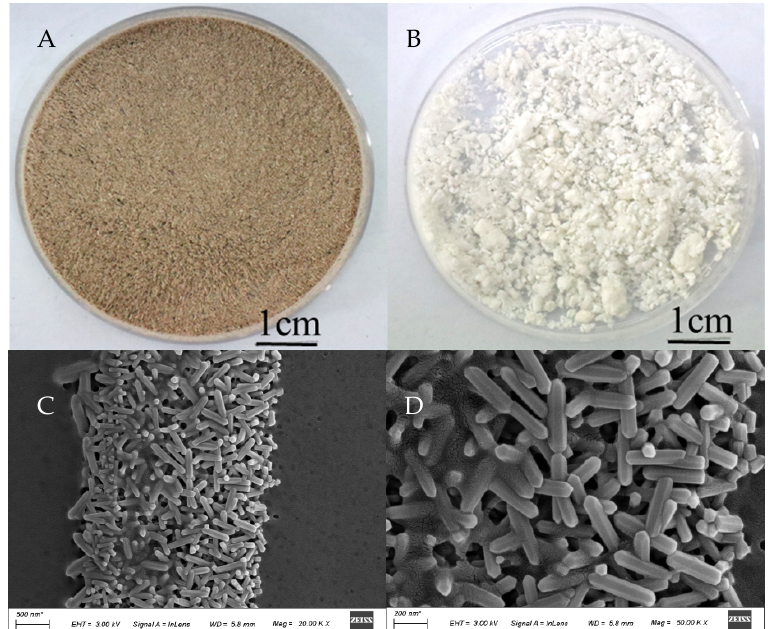
Figure 7. Crystalline index and degree of polymerization of CNC in polyploid Miscanthus lutari- oriparius and Miscanthus × giganteus .* Significant difference at p ≤ 0.05. Vertical bar are standard de- viation ( n = 3).